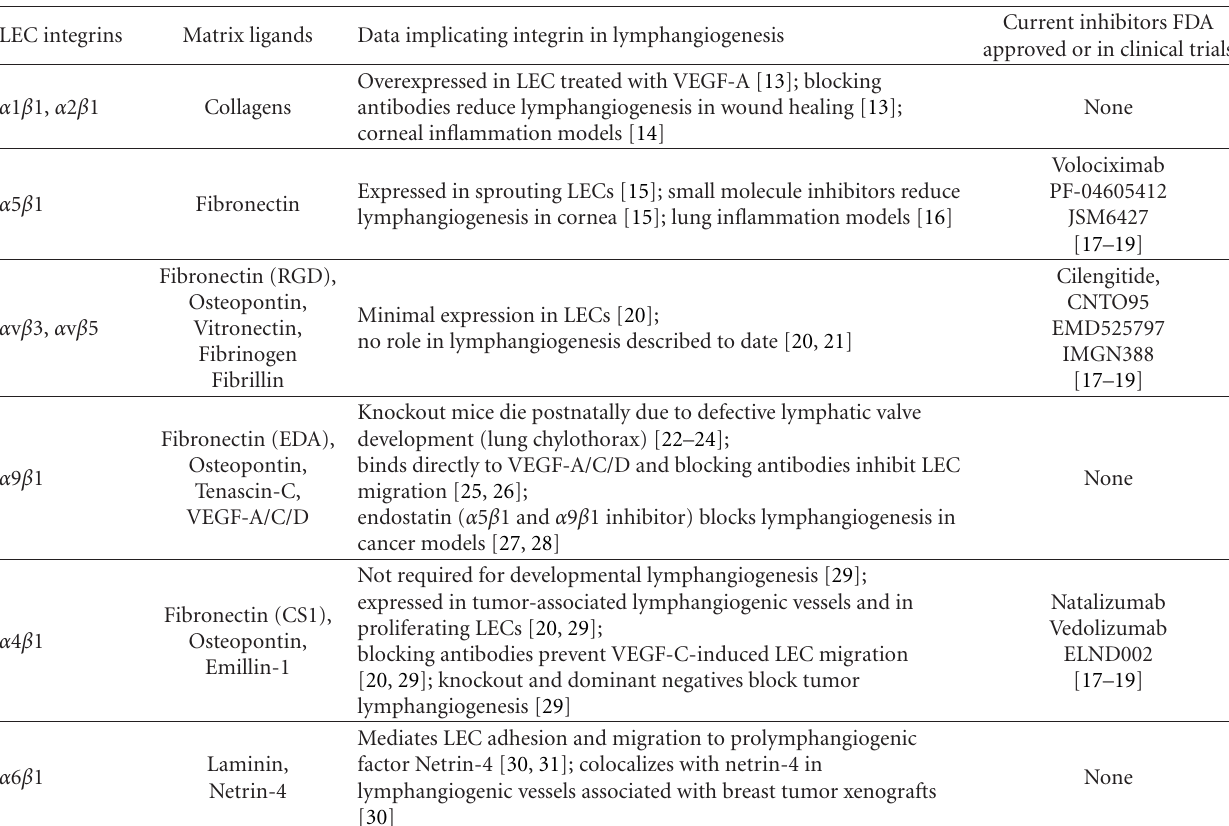
Table 1: Integrins in